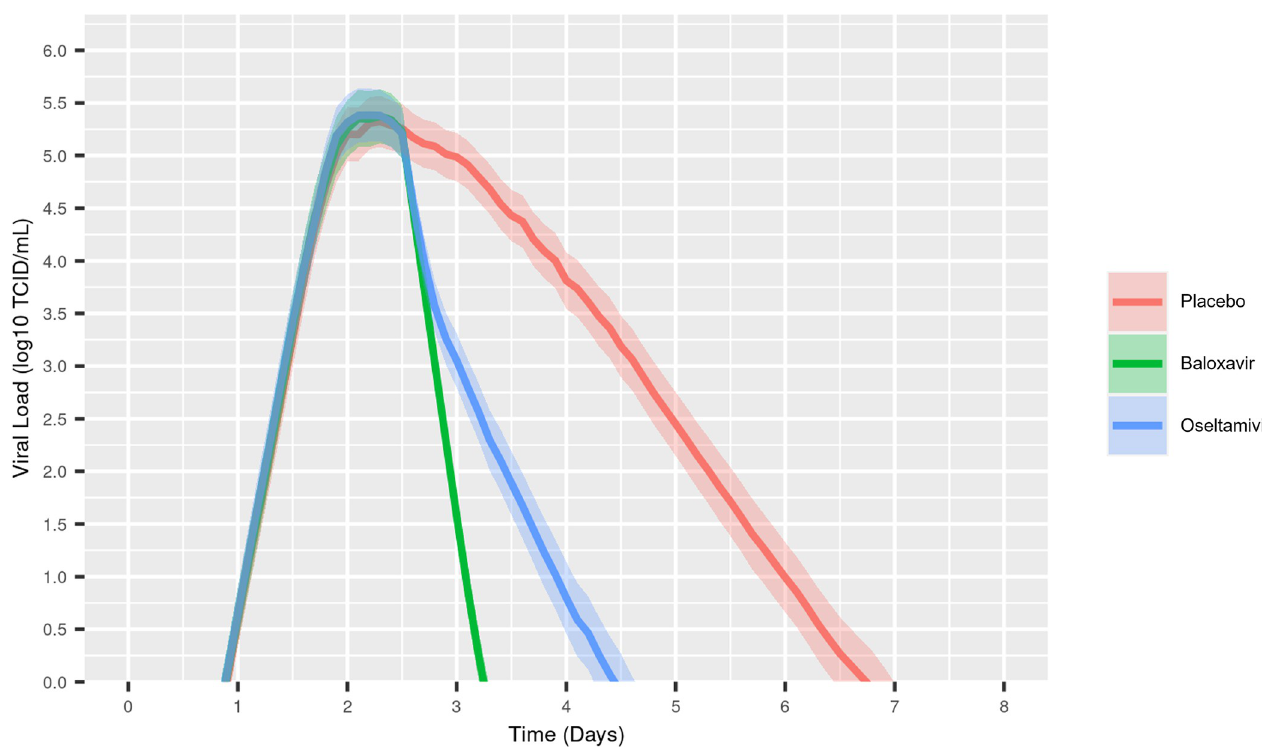
treatment at different initiation time points. The effects of antiviral treatment with baloxavir or oseltamivir on influenza transmissibility over time, estimated using natural-scale, log-scale, and dose–response models, are shown in Fig 4. There was substantial inter-person variation in infectiousness as well as response to drug mitigation and thus transmission mitigation (i.e.,